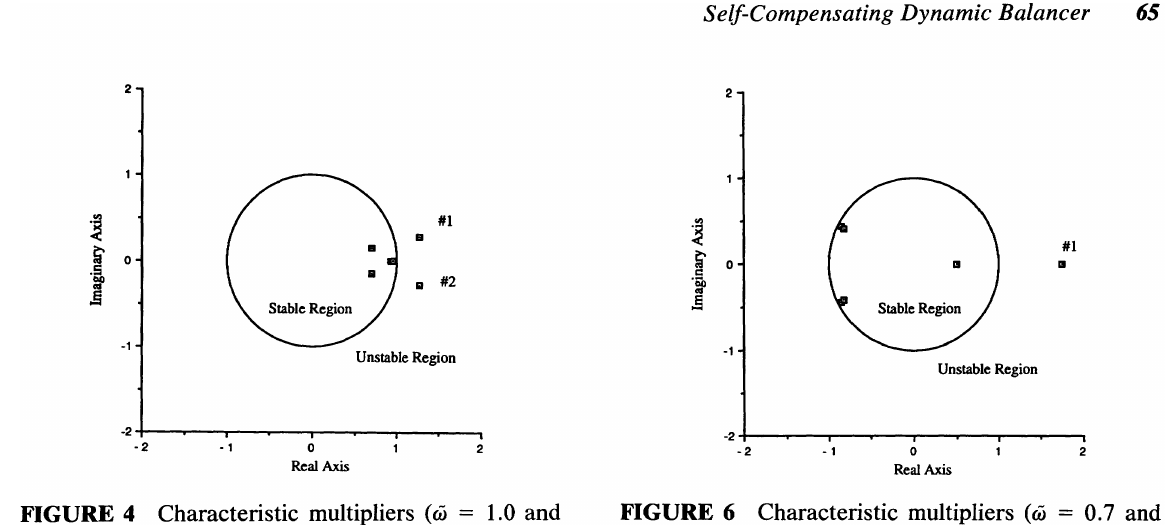
FIGURE 4 Characteristic multipliers (eli = 1.0 and {3' = 0.01 case). Characteristic multipliers: 1.2712 ±